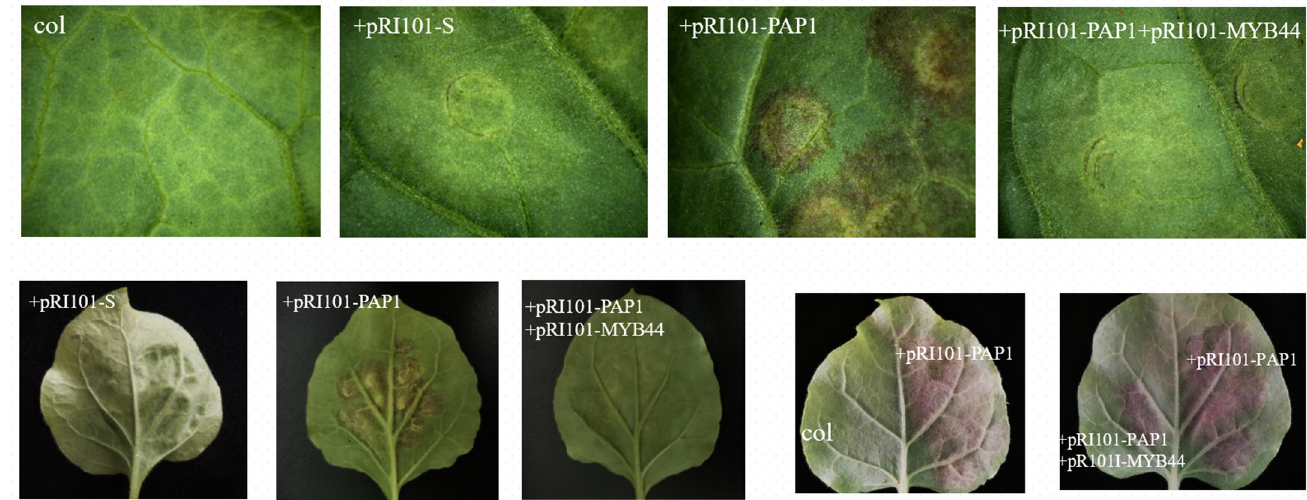
Figure 5. Transient color determination of BcPAP1 and BcMYB44 protein activity in N. benthamiana. The first row were partial views of N. benthamiana leaves under a microscope, and the second row were whole views of N. benthamiana leaves. (col: blank control; pRI101-S: empty vector control).